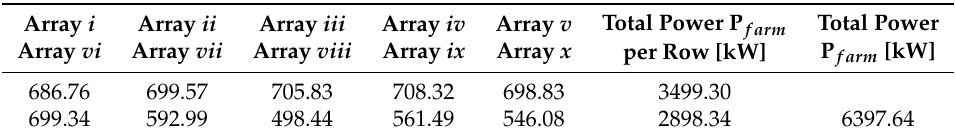
Table 7. Power output in kW for the 50 WEC farm for an irregular wave of H m 0 = 1.80 m